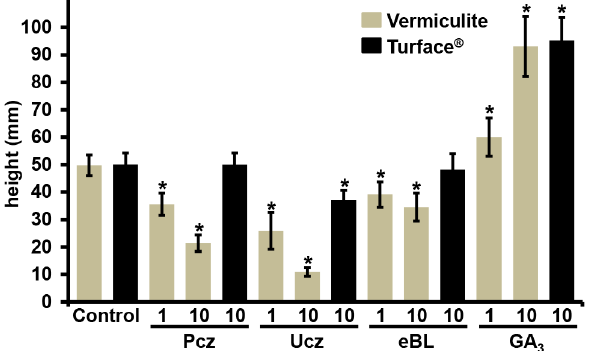
Figure 8. Growth responses of B73 seedlings to Pcz, Ucz, eBL and GA on Turface and vermiculite 3 media. Light grown B73 seedlings grown onTurface (black bars) and vermiculite (grey bars) treated with1 and m M Pcz, Ucz, eBL and GA for 9 d. Seedlings grown on vermiculite were treated with 1 and 10 3 m M conce- 10 m M concentrations of each ch- ntration of each chemical. Seedlings grown on Turface were treated with 10 emical. Error bars represent standard deviation. Statistically significant differences to controls are indicated p , 0.01). with asterisks determined by student’ s t-test